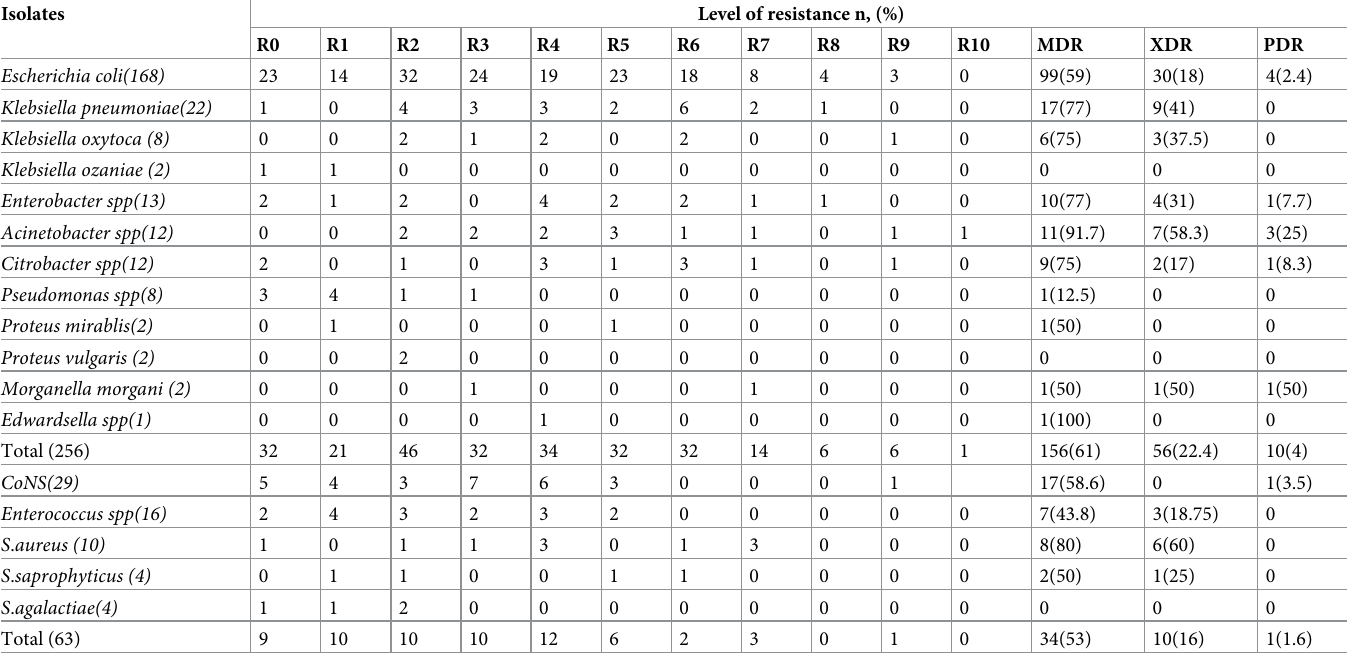
Table 5. Level of resistance of uropathogens bacterial isolates from urine